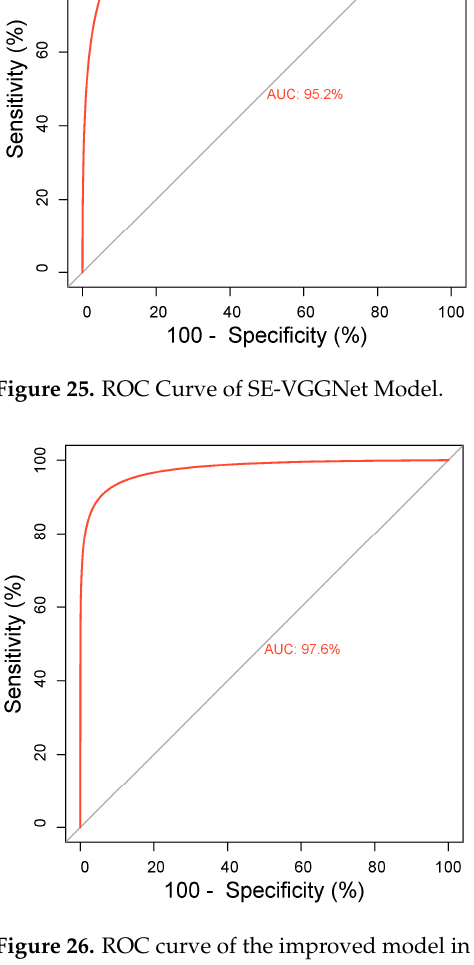
Figure 26. ROC curve of the improved model in this paper.